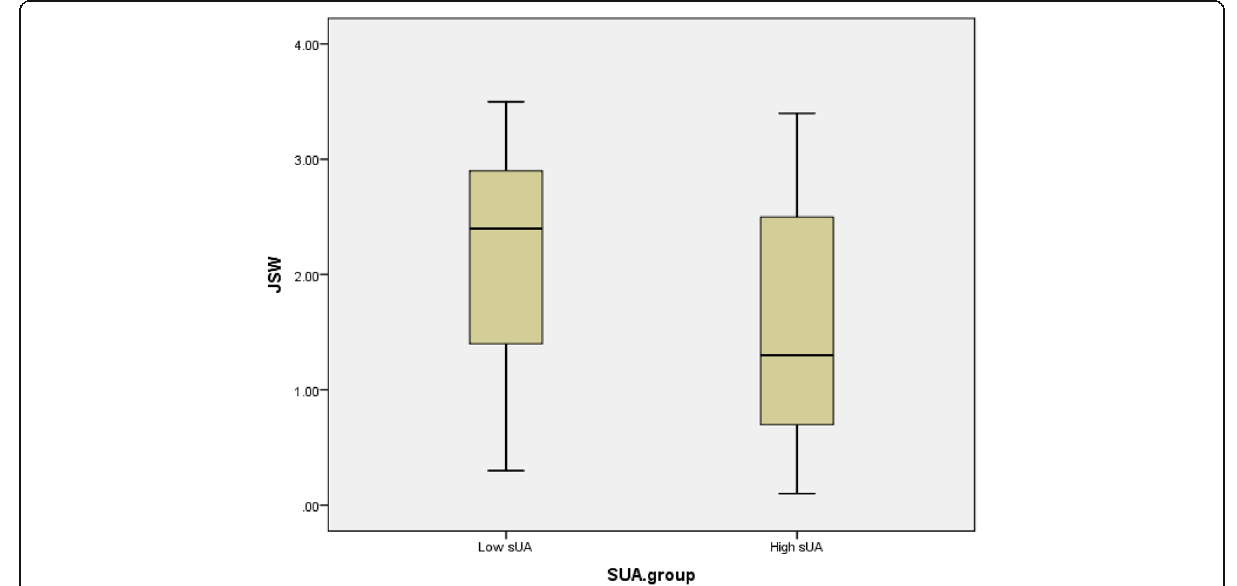
Fig. 3 Comparison of the JSW between female KOA patients in L-sUA group versus H-sUA